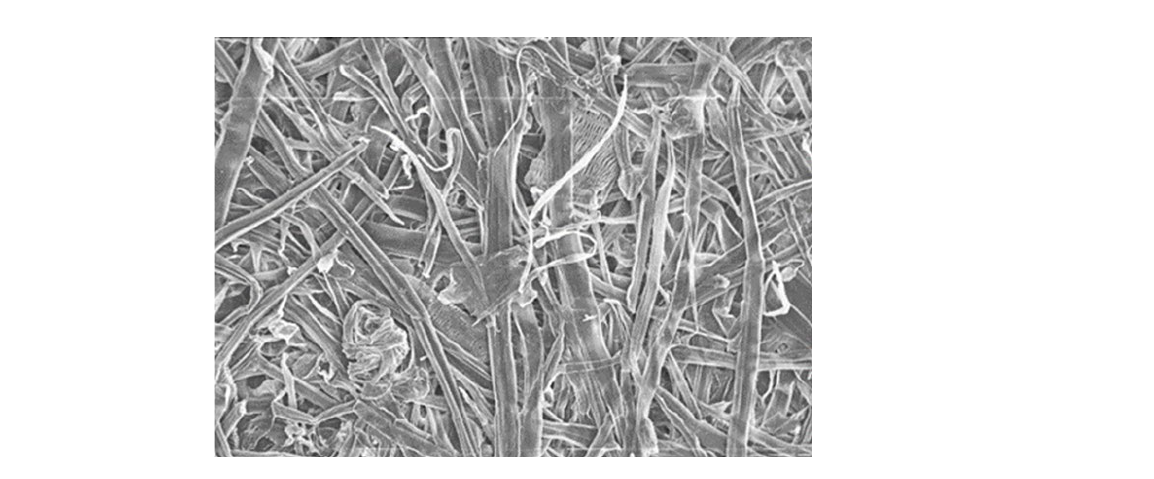
Figure 1. Scanning electron micrographs of OPT chemi-themomechanical pulps at 200× magnification.